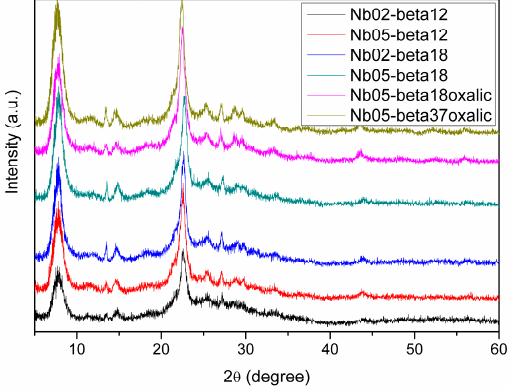
Figure 3. X-ray diffraction patterns of Nb- β samples.